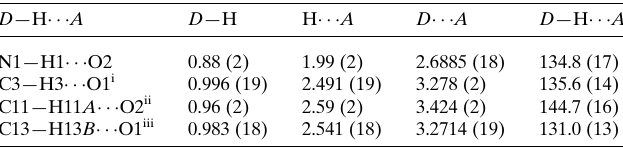
Table 1 Hydrogen-bond geometry (A˚ , (cid:5) ).